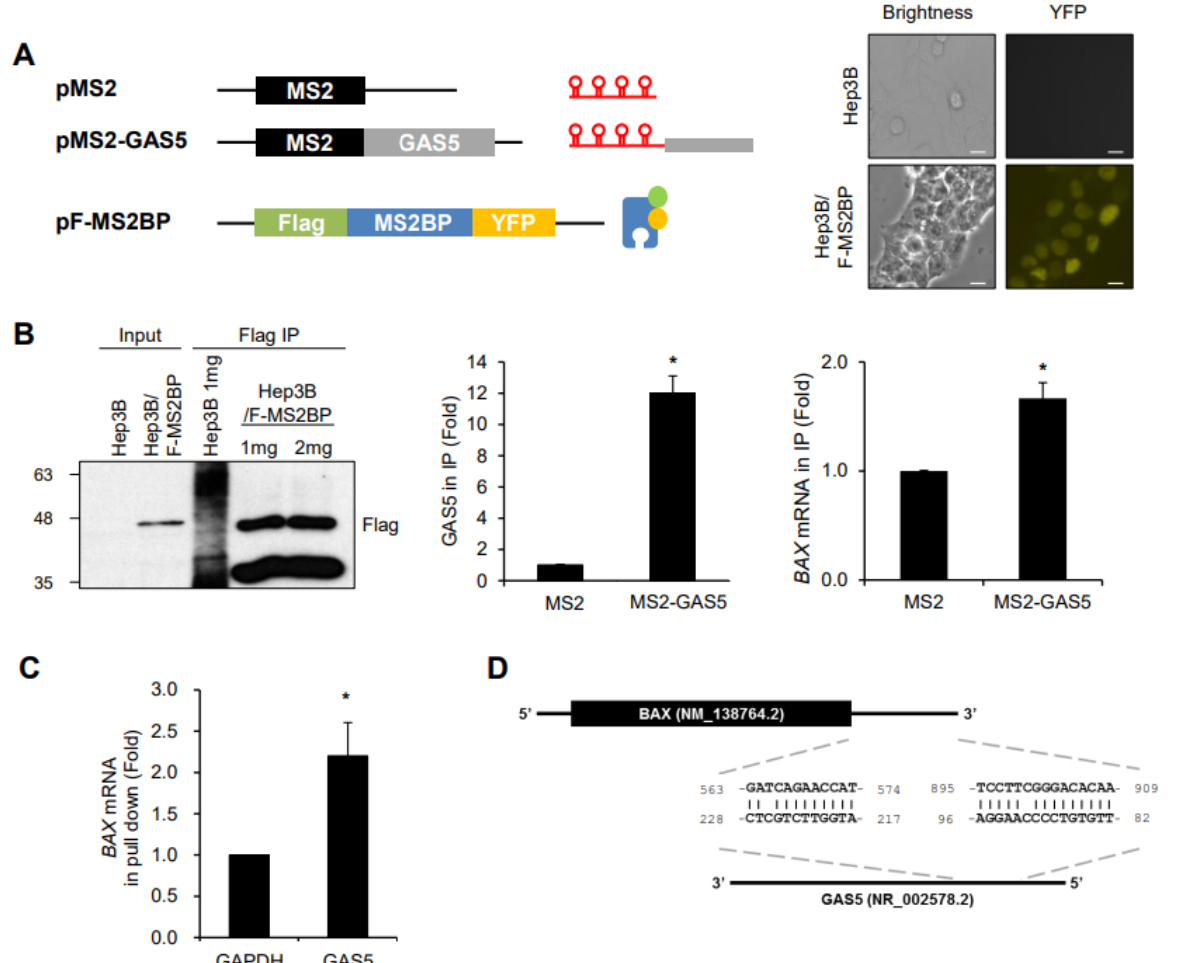
Figure 3. Association between GAS5 and BAX mRNA. ( A ) Schematics of the MS2-trap system. GAS5 was cloned behind MS2 hairpin sequences of pMS2 to generate pMS2-GAS5. A plasmid encoding Flag-tagged MS2BP-YFP (pFlag-MS2BP) was transfected with Hep3B cells to establish a stable cell line expressing Flag-MS2BP (Hep3B/F-MS2BP). The fluorescence of YPF was observed using a fluorescence microscope. Scale bar, 20 µ m. ( B ) After transfection of pMS2 or pMS2-GAS5, the F-MS2BP containing ribonucleoprotein complex was isolated from the cell lysates using Flag Ab-coated beads, and the enrichment of F-MS2BP in the complex was shown by western blotting analysis (left). Relative levels of GAS5 and BAX mRNA in the complex were assessed by RT-qPCR (right). ( C ) Biotin pull-down assay. Biotin-labeled GAS5 was generated and incubated with HCT116 cell lysates. The GAS5-containing RNA complex was isolated using a Streptavidin bead, and the association between GAS5 and BAX mRNA in the complex was analyzed by RT-qPCR. GAPDH mRNA was used for the normalization. ( D ) In silico analysis of the interaction between GAS5 and BAX mRNA using the BLAST algorithm. Data were expressed as the mean ± SEM, and images are representative of three independent experiments. The statistical significance of the data was analyzed via Student’s t -test; *, p < 0.05.